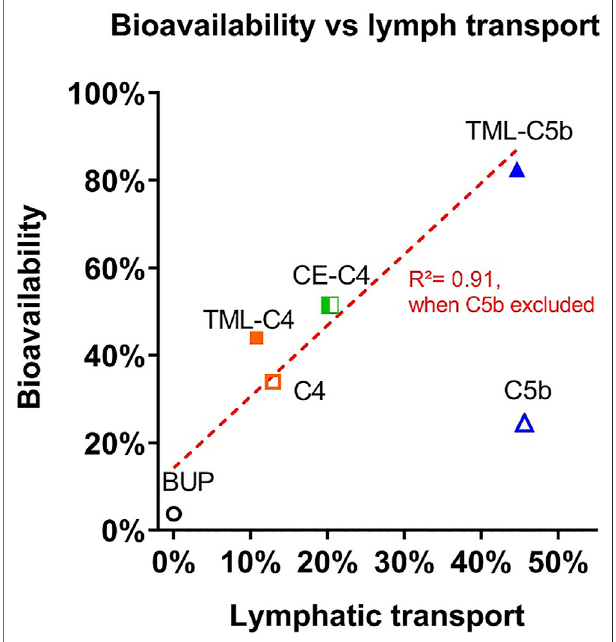
FIGURE 8 | Comparison between oral bioavailability and lymphatic transport of the BUP